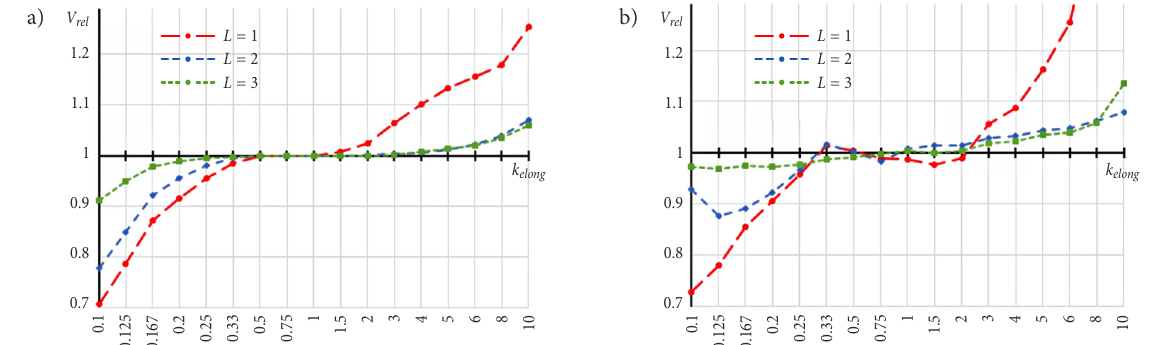
Fig. 2. Variations of relative volumes of elongated (flattened) quasi-quadric particles obtained by LRSH with different values of expansion degree L : a) quasi-ellipsoids; b) of quasi-prisms